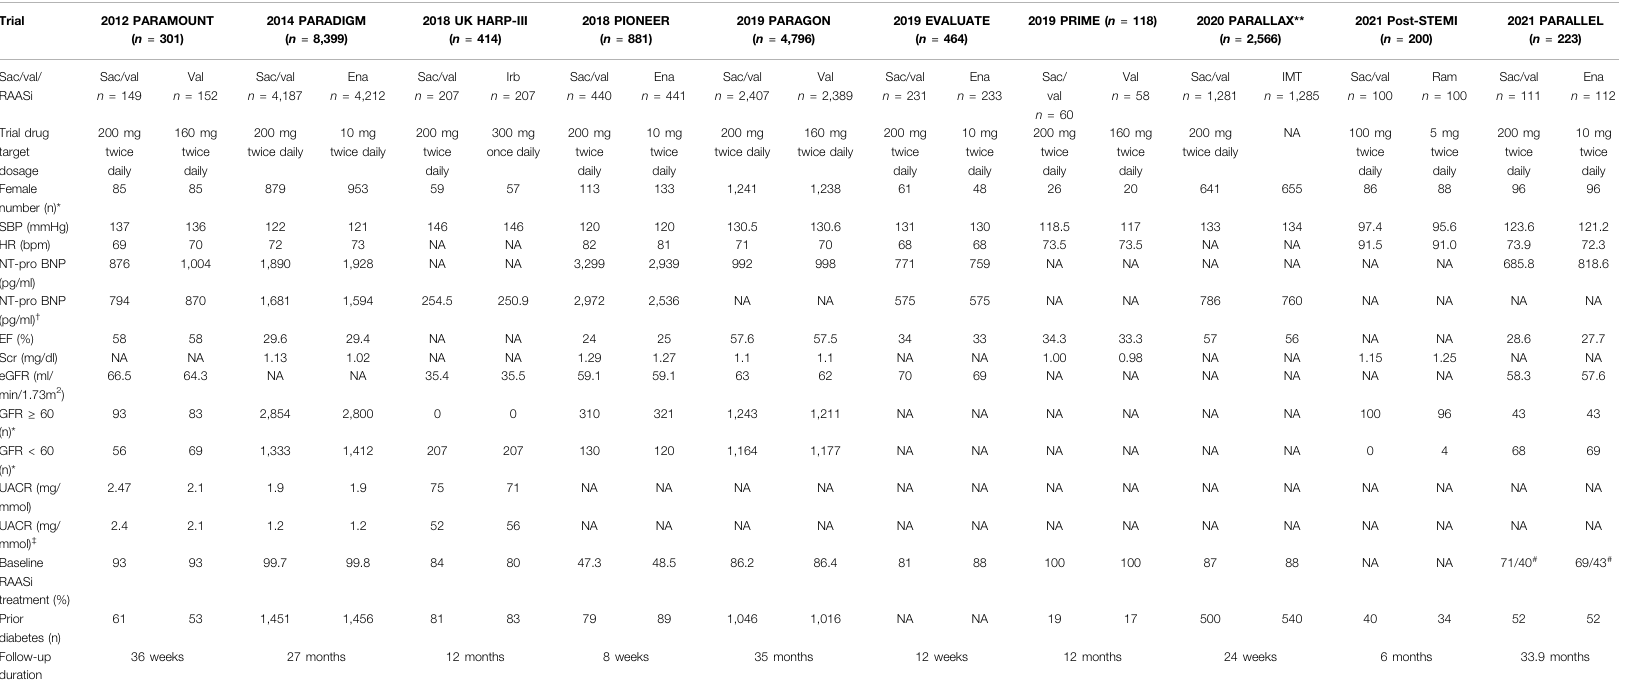
TABLE 1 | Baseline characteristics of included